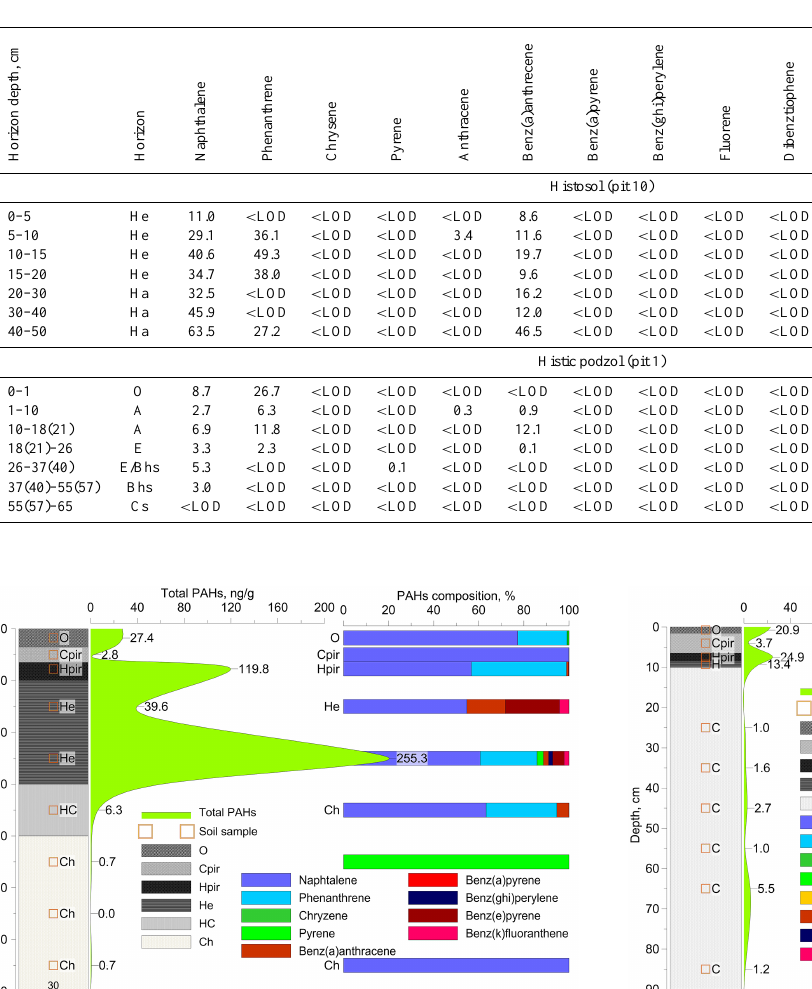
Table 2. PAH concentrations (ngg − 1 ) in soils of unburned area.